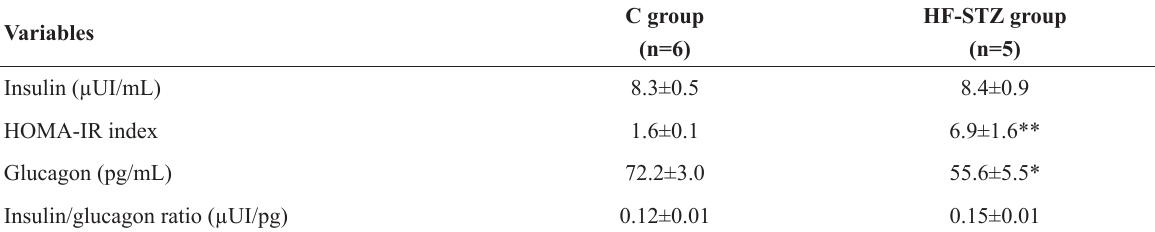
Hormonal analyses of male rats subjected to control diet (C) or high-fat diet/ streptozotocin